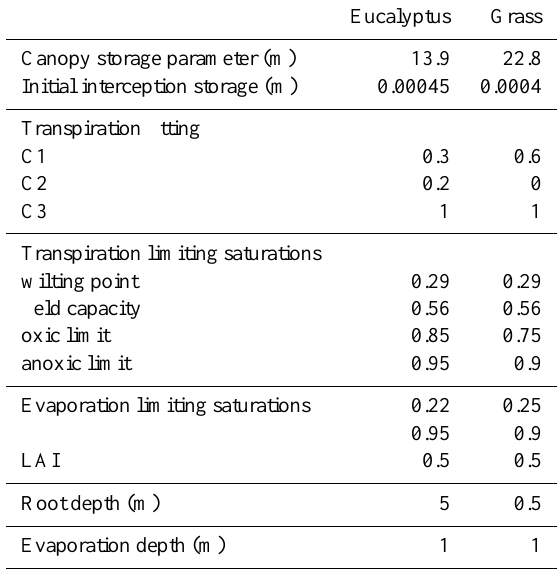
Table 3. ET component parameters values for the study site. Table 4. Results of the calibrated model performance Eucalyptus